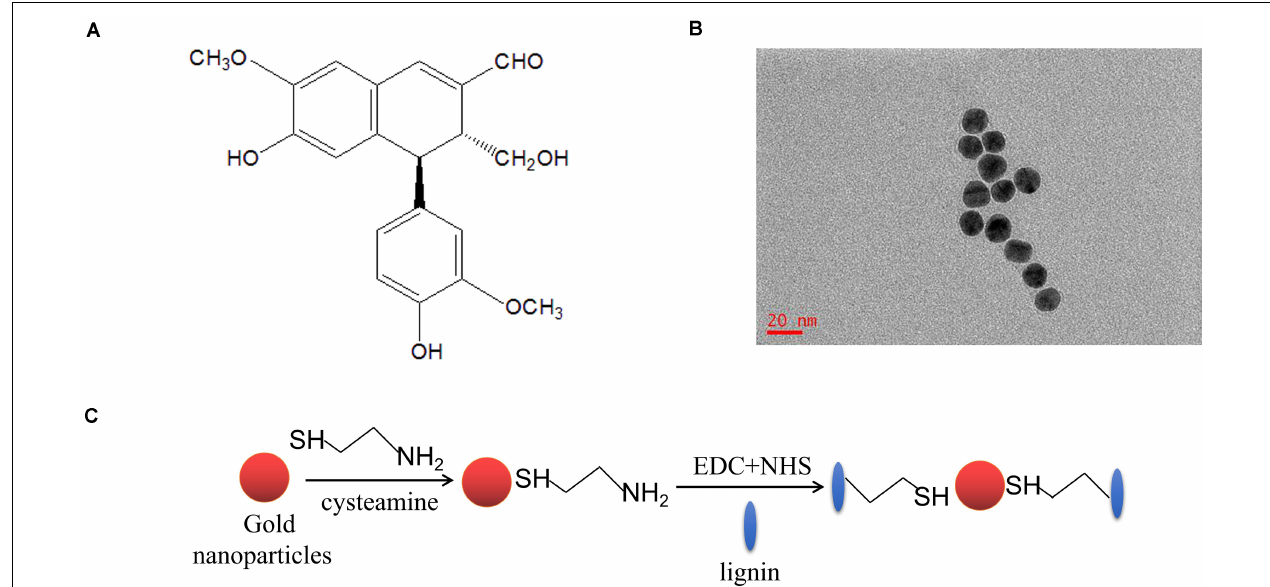
FIGURE 2 | VB1 is linked with modified gold nanoparticles for further HPLC and immunoprecipitation. (A) The chemical structure diagram of VB1. (B) The gold nanoparticles were synthesized and shown in the transmission electron microscope (TEM) image. (C) Gold nanoparticles was modified by lignin via reacting with